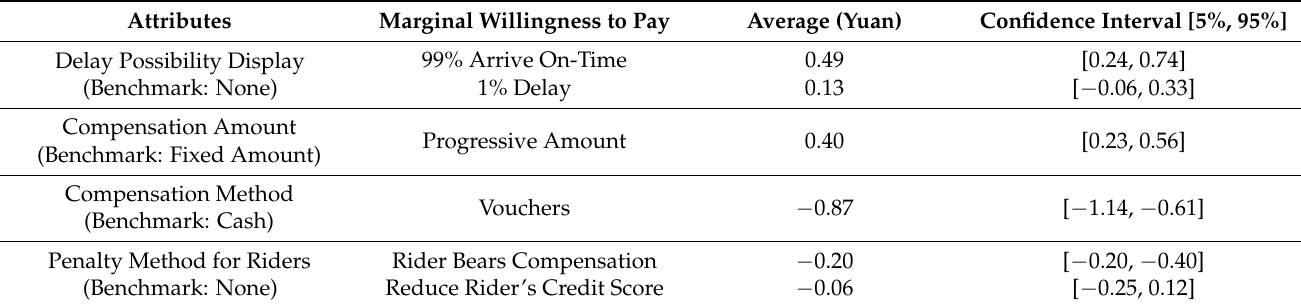
Table 5. Estimation of willingness to